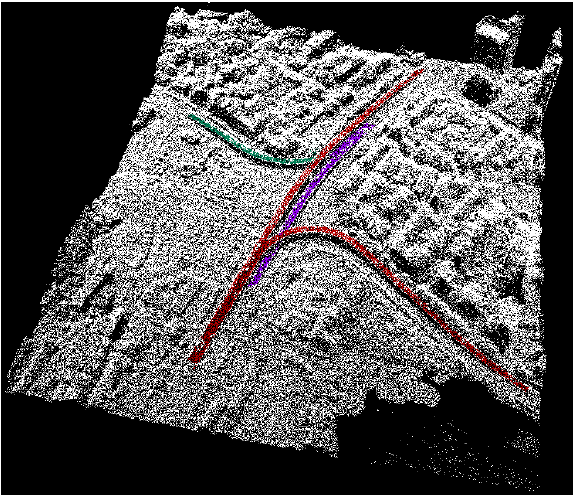
Figure 5. Viaducts Extraction Result by Seed